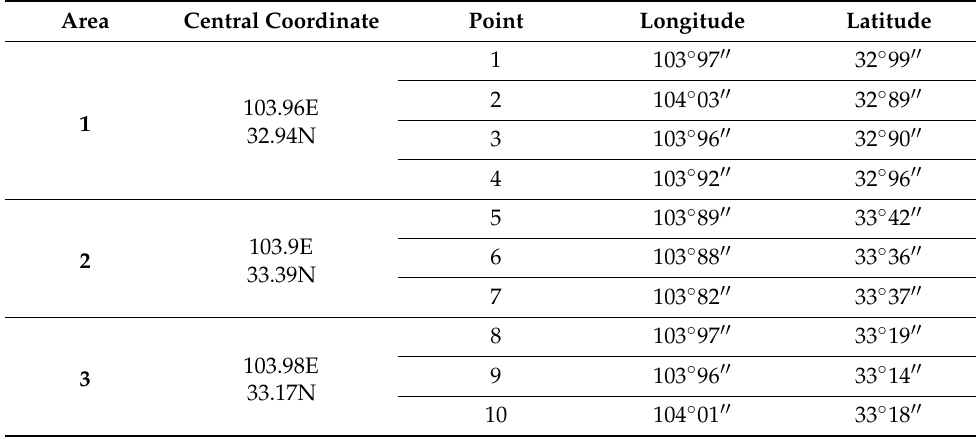
Figure 15. Jiuzhaigou earthquake 20170818–20180226 average vertical velocity map. Table 6. Sampling area information and sampling point distribution information.